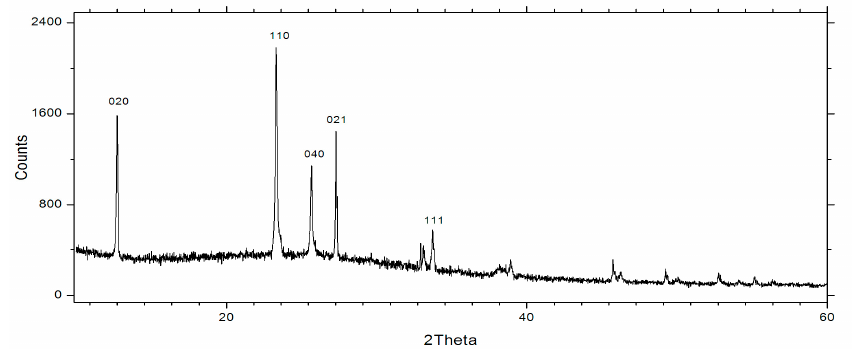
Figure 2. The XRD spectra of thermally evaporated MoO 3